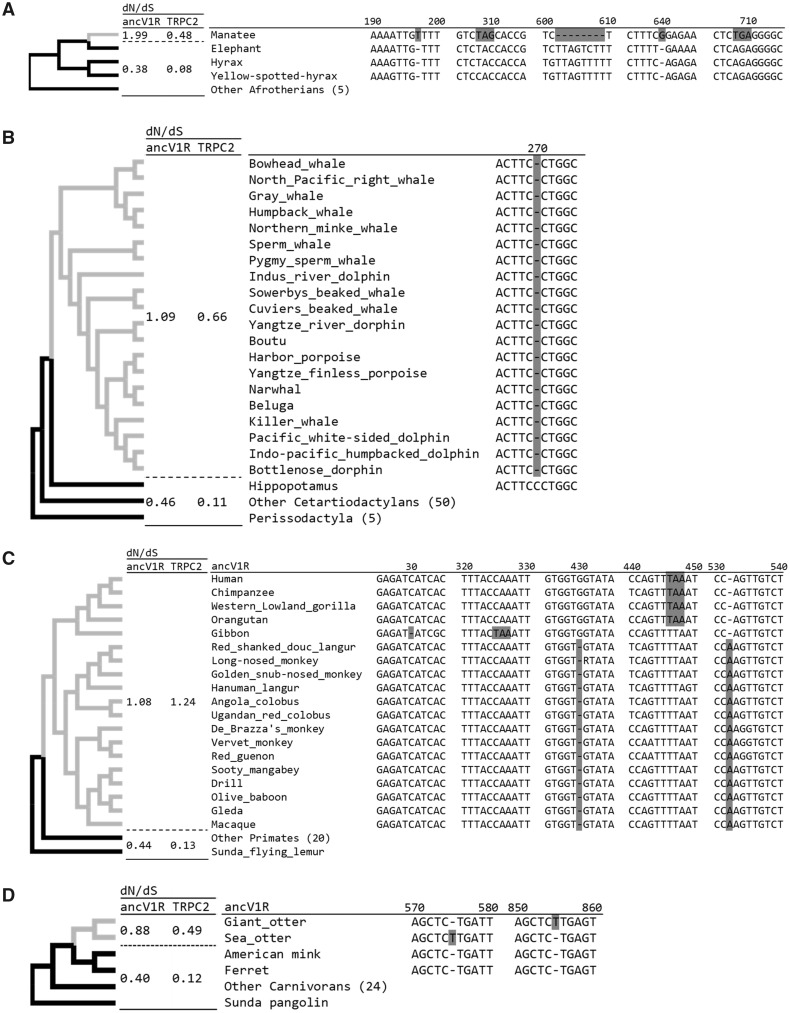

—The sequence alignments of ancV1R showing the inactivating mutations shared among each family for the manatee (A), cetaceans (B), catarrhines primates (C), otters (D), true seals (E), the fossa (F), the owl monkey (G), alcelaphine antelopes (H), and bats (I), with closely related outgroups. Inactivating mutations are highlighted in gray. Start codon mutations and stop codon mutations are highlighted in yellow and blue, respectively. Each alignment is extracted from the alignment of all ancV1R sequences used in this study (supplementary alignment file 1, Supplementary Material online). The numbers above the line indicate the nucleotide positions for each alignment. The colors of each branch indicate different ω categories. The ω values of ancV1R and TRPC2 for each branch are indicated in the dN/dS columns.